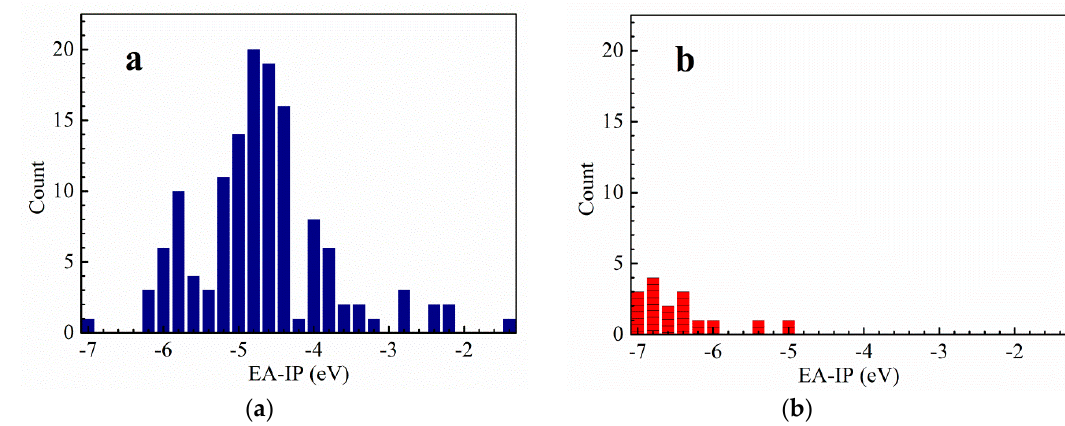
Figure 4. The difference between VEA of the cation and VIP of the anion for common energetic salts ( a ) and cyclo -N 5 − salts ( b ) at DFT-B3LYP / aug-cc-pVTZ level in water.